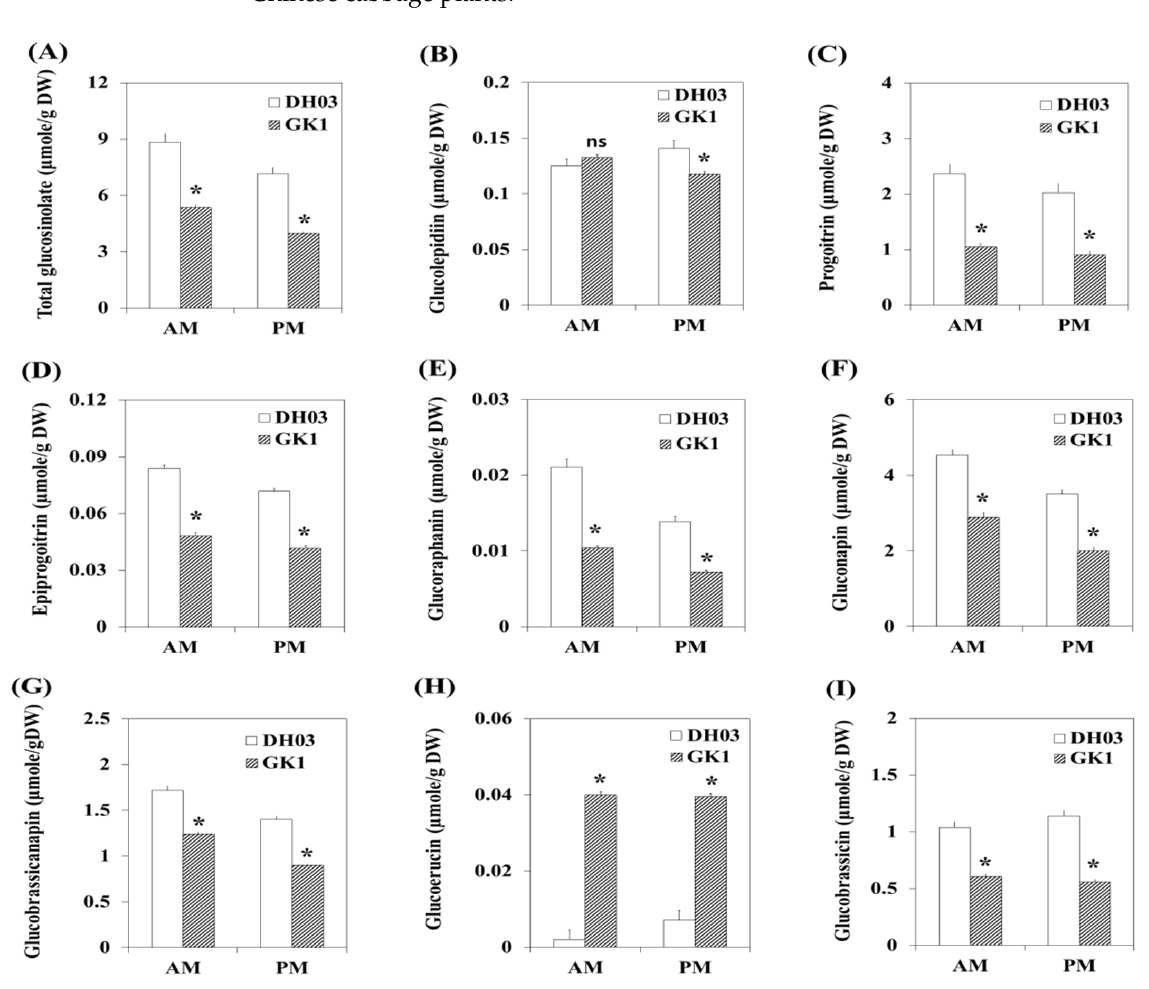
Figure 7. Diurnal accumulation of GSL in DH03 and GK1 grown under 16/8 h light/dark conditions. Samples were collected at 10 a.m. and 5 p.m. in liquid nitrogen and stored at − 80 ◦ C prior to lyophilization. Total GSLs ( A ), glucolepidiin ( B ), progoitrin ( C ), epiprogoitrin ( D ), glucoraphanin ( E ), gluconapin ( F ), glucobrassicanapin ( G ), glucoerucin ( H ), and glucobrassicin ( I ). Each value is the mean of three biological replicates, and error bars indicate the standard deviations (SDs). * p < 0.05 compared to the negative control (DH03). ns = not significant compared to the negative control sprouts (DH03).